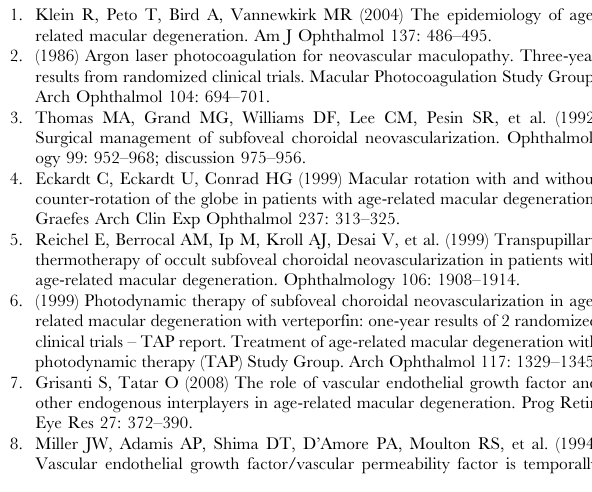
Figure S1 The size of the devices. The size of the device was